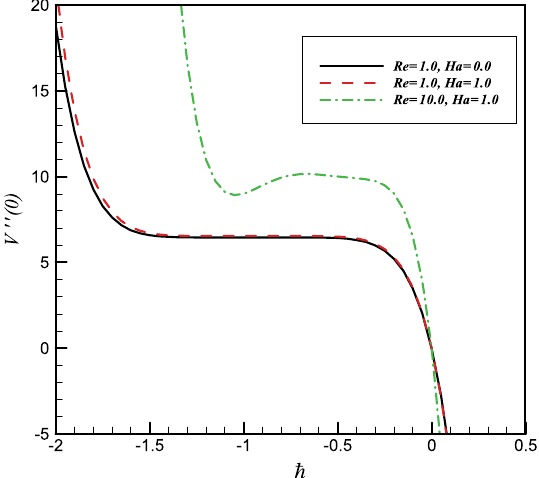
Fig. 2. The (cid:1) - curve of V (cid:2)(cid:2) (0) given by the 10th-order approximate solution, for various values of Re and Ha, [45]. range of admissible values of the auxiliary parameter ~ , for various values of Re and Ha, the curves of ~ are plotted in Figs. 2 and 3 associated with the 10th- order approximation. The optimal value of auxiliary